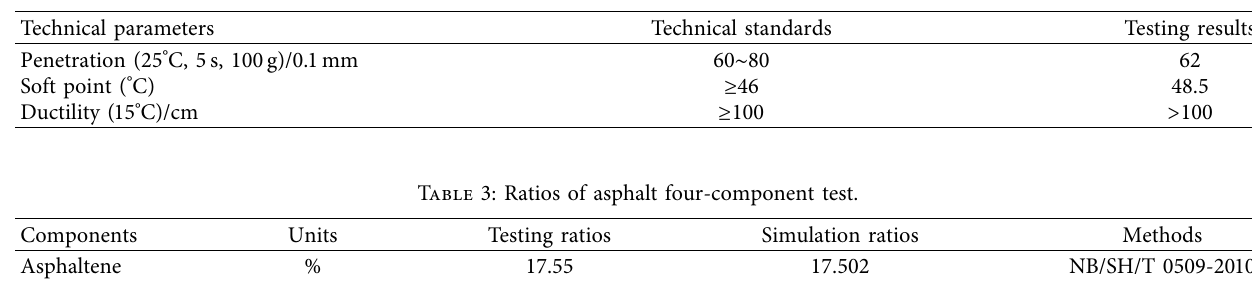
Table 2: Technical parameters of 70# base asphalt.